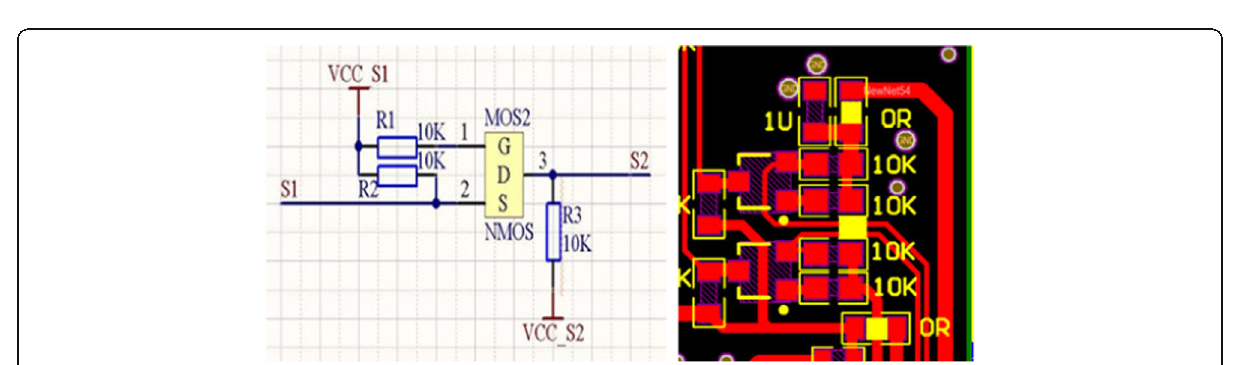
Fig. 29 The conversion circuit between 3.3 and 5 V